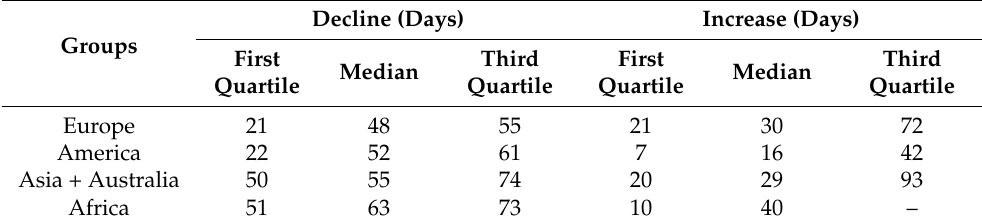
Table 3. Quartiles of duration ( N = 108). Source: own elaboration, Statistica.